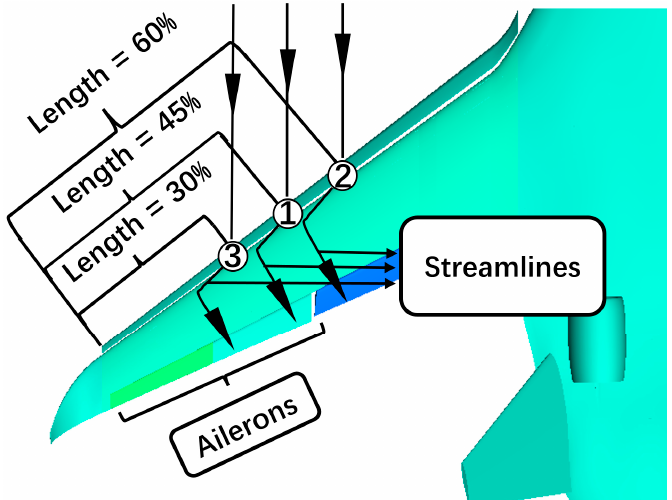
Figure 16. Parameterization of the length of the outboard Krueger flap for sensitivity analysis.